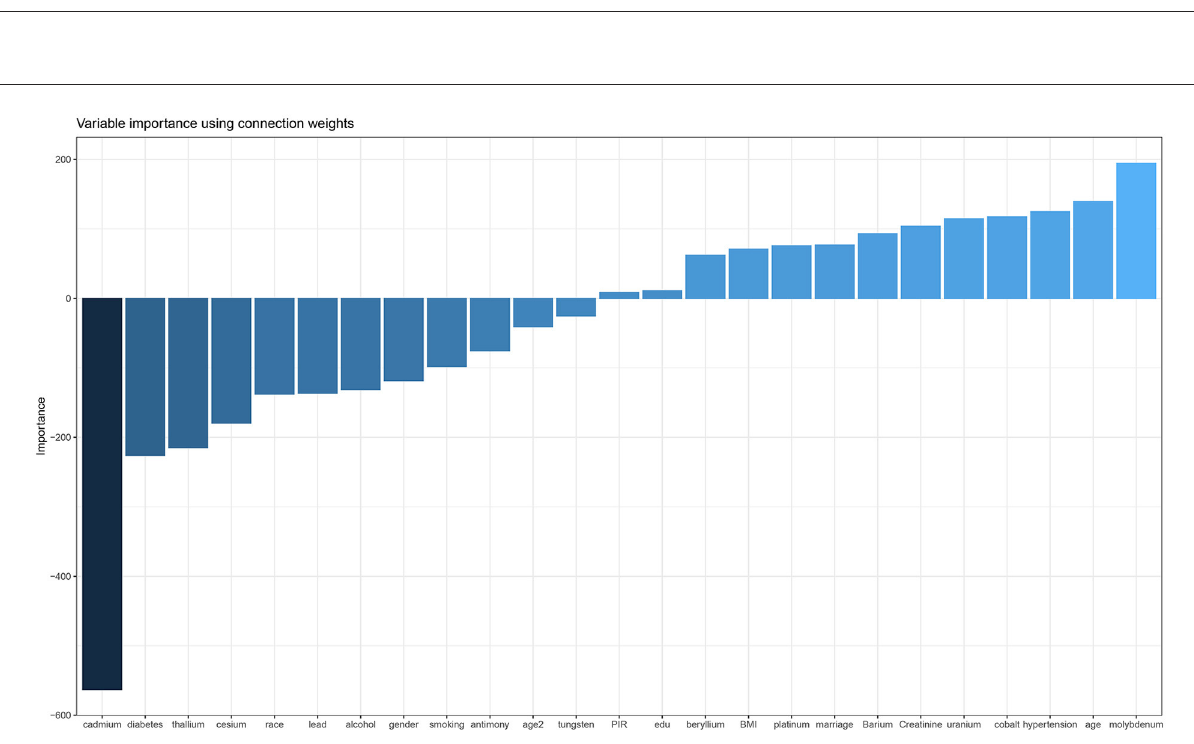
FIGURE3 Variable importance plot of